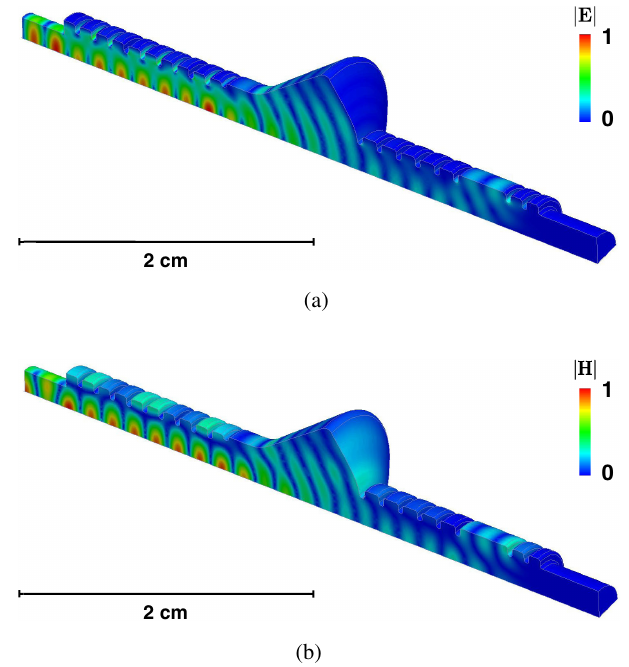
FIG. 8. Surface field profiles of the reflecting end section, adapted from Toufexis et al. [22]. (a) Electric field and (b) magnetic